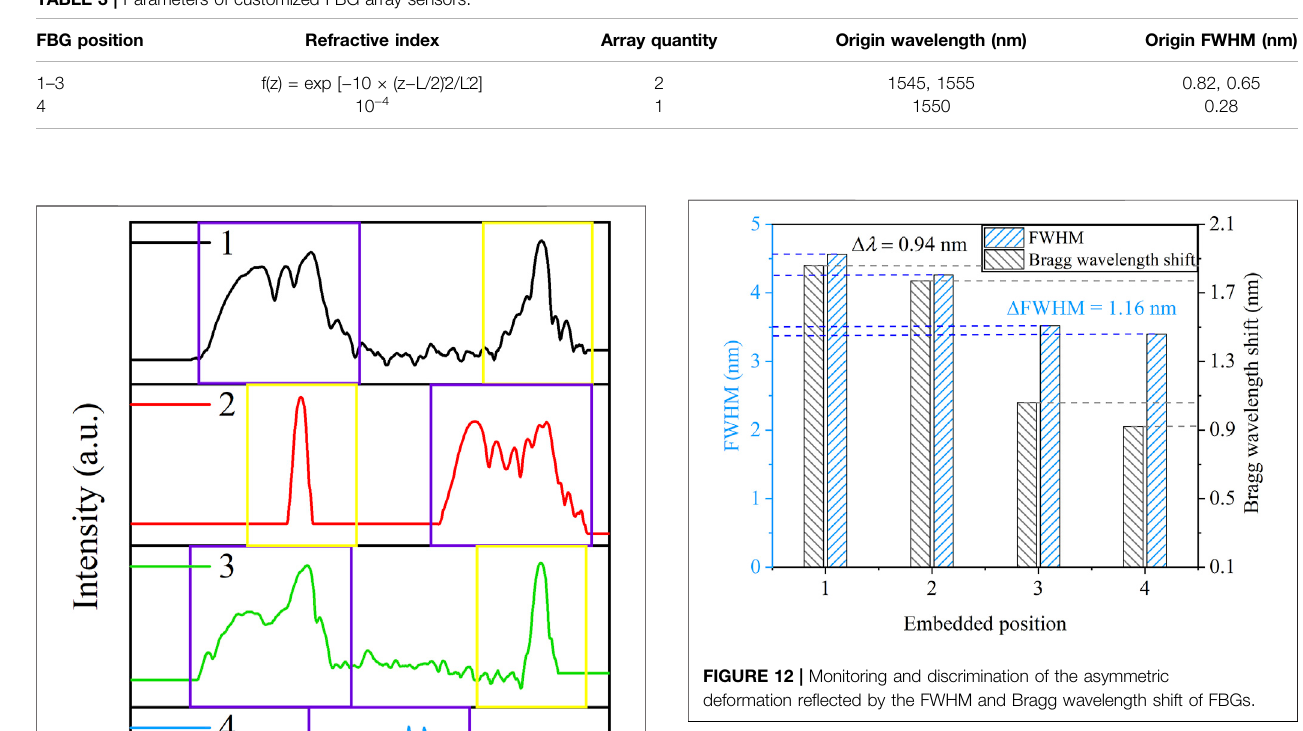
TABLE 3 | Parameters of customized FBG array sensors.